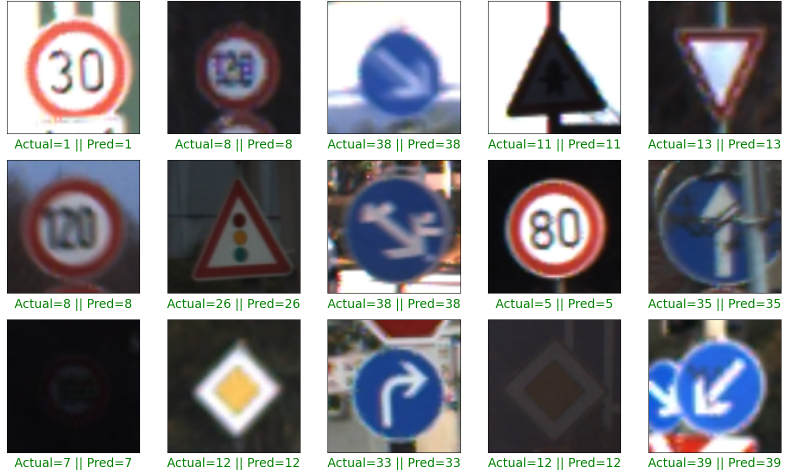
Figure 5. Detection and classification performance of proposed model on